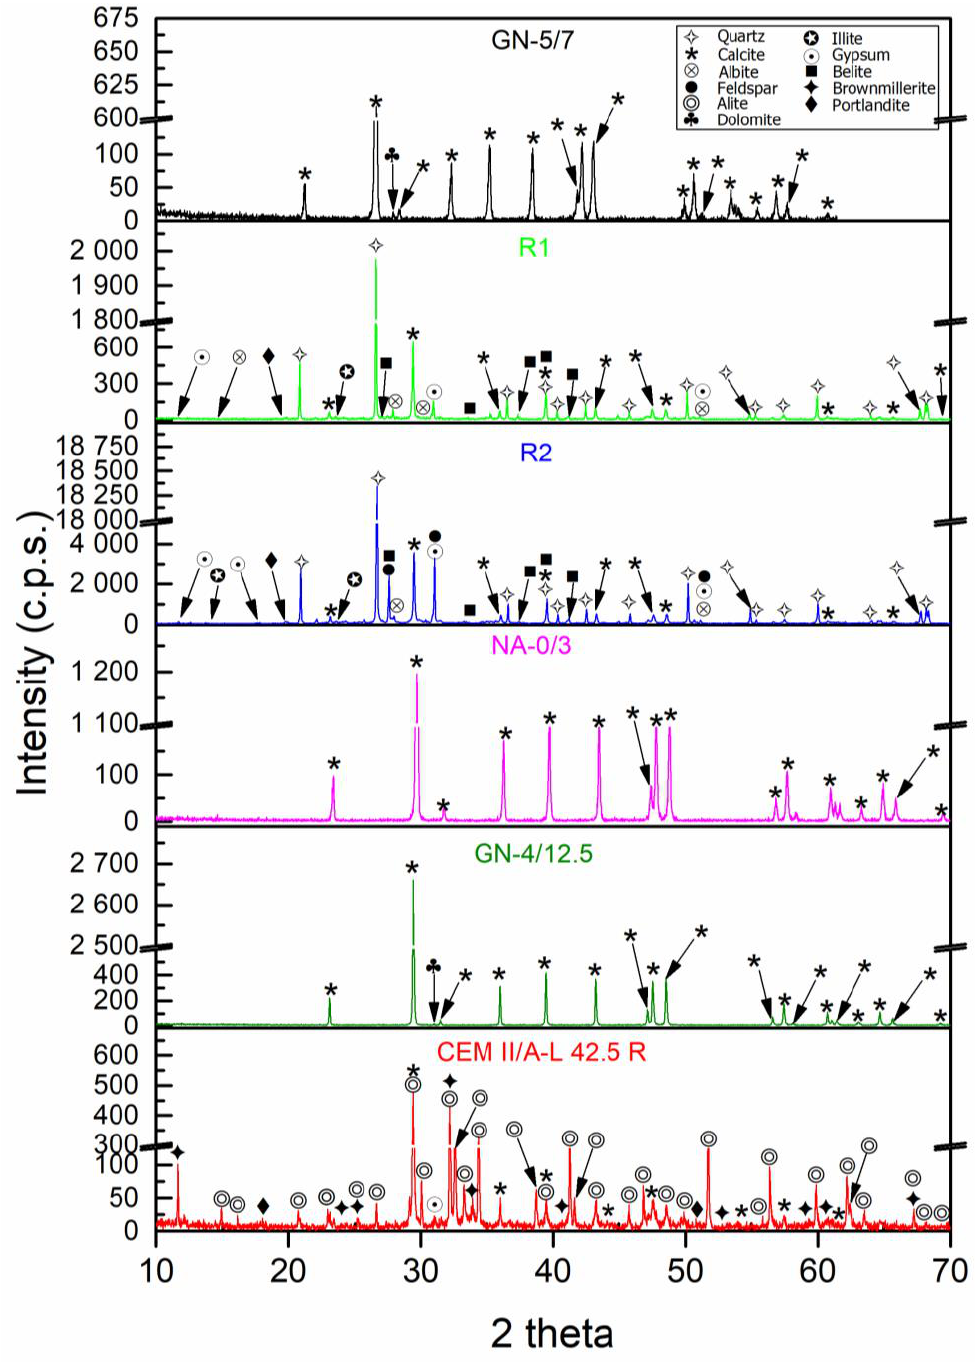
Figure 2. X-ray diffraction patterns of raw materials used for the different mixtures.